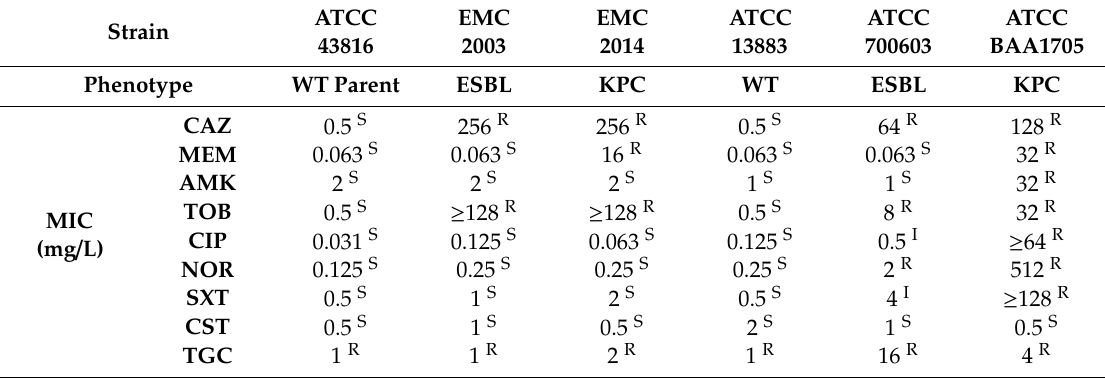
Table 1. Minimum inhibitory concentration (MIC) values of clinically relevant antibiotics for K. pneumoniae